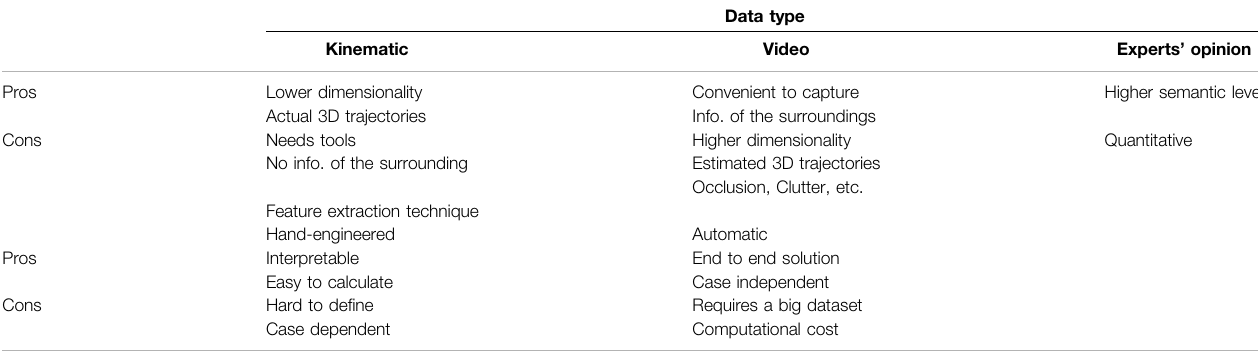
TABLE 1 | Summery of different sources of data and different feature extraction